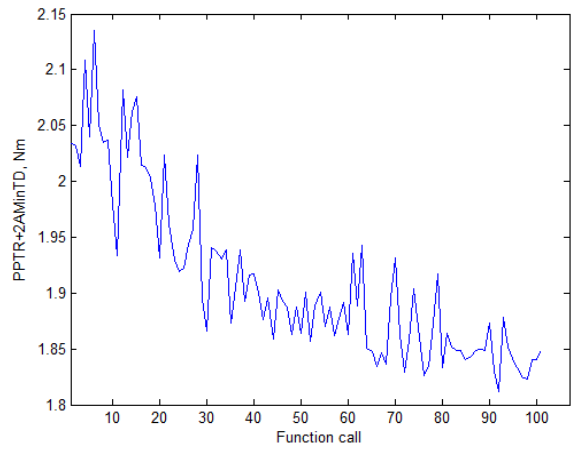
Figure 13. Change of the motor efficiency during the second optimization.